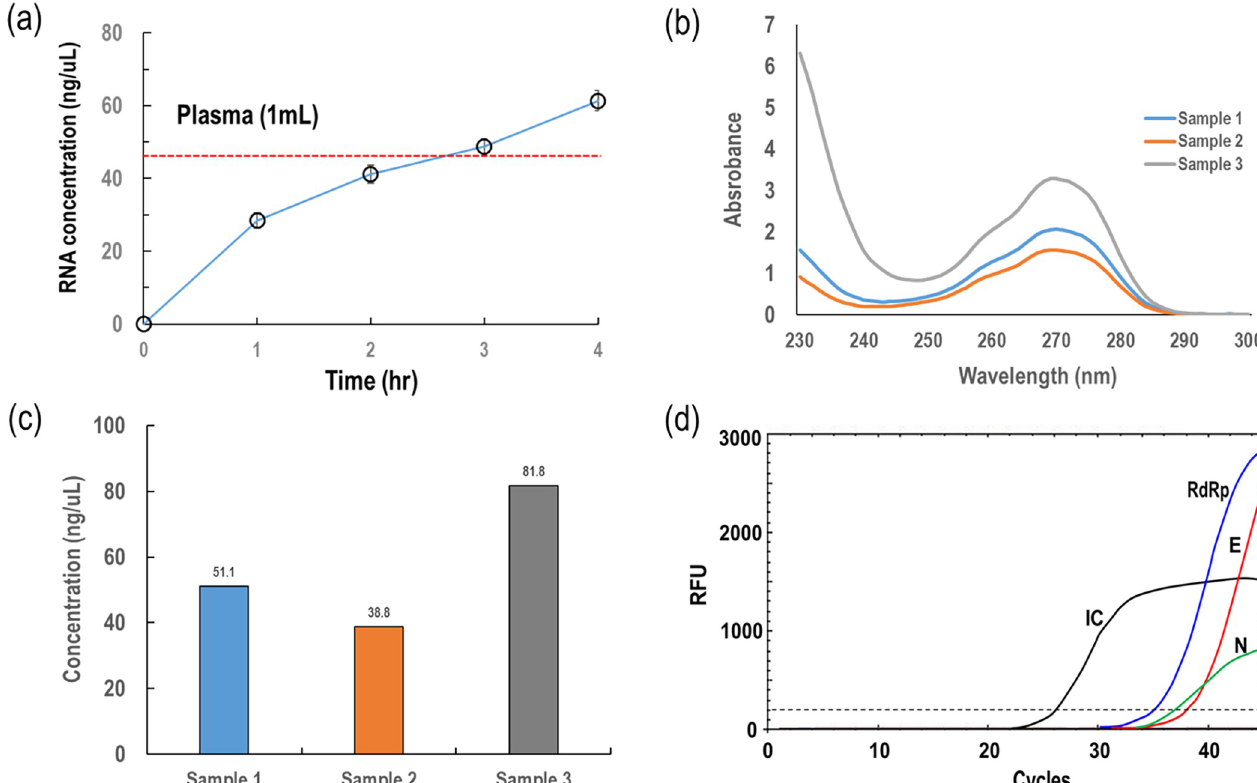
Fig 2. (A) Collected nucleic acid quantity with mask wearing time; (B) absorbance spectrum results for three different masks; (C) concentration of collected RNA from three masks; (D) PCR results of a clinical mask